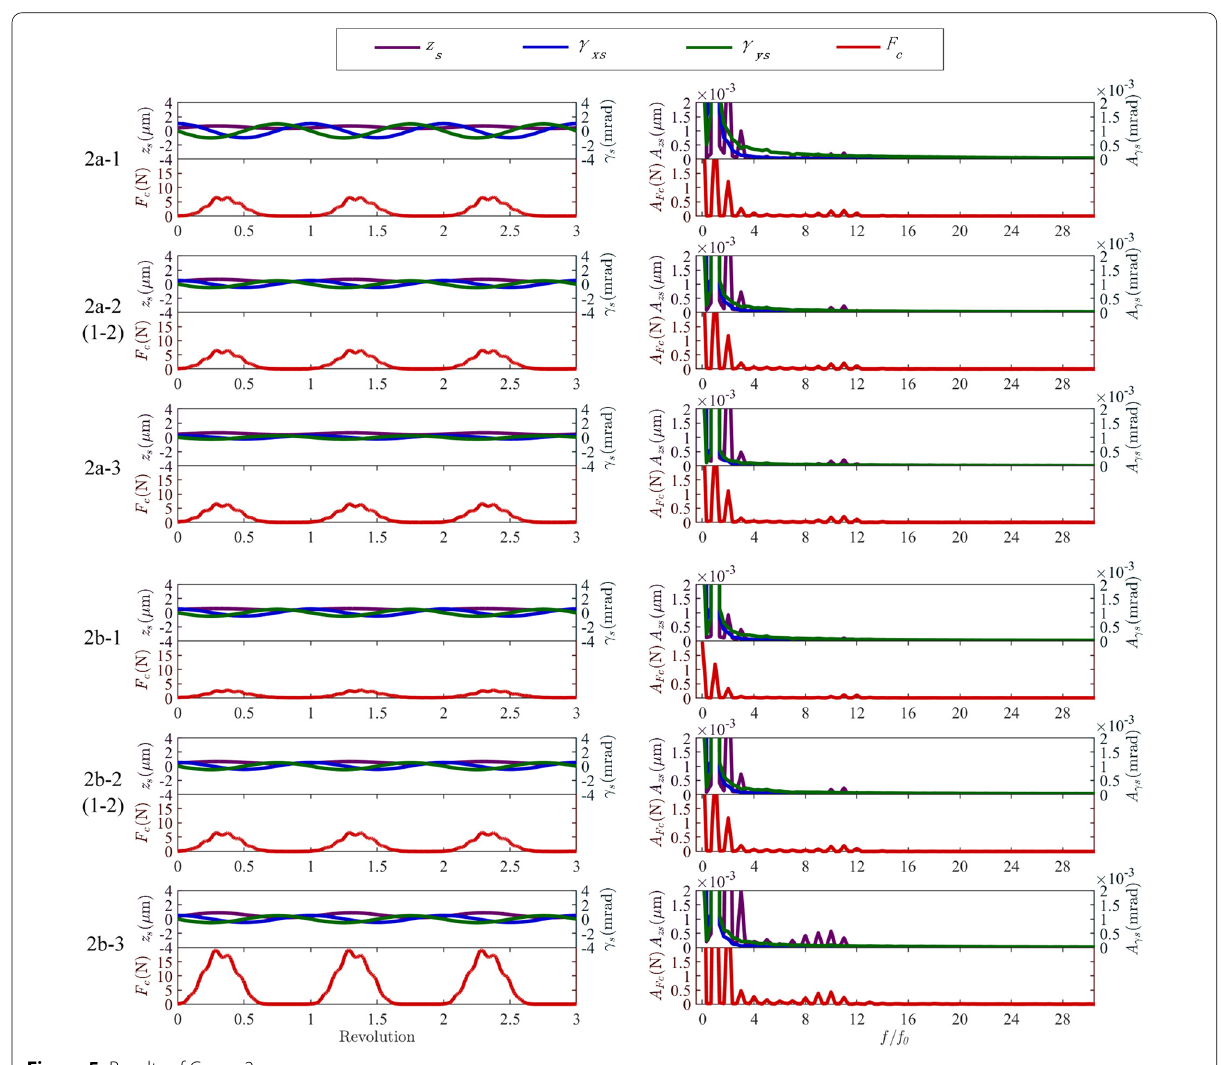
Figure 5 Results of Group 2